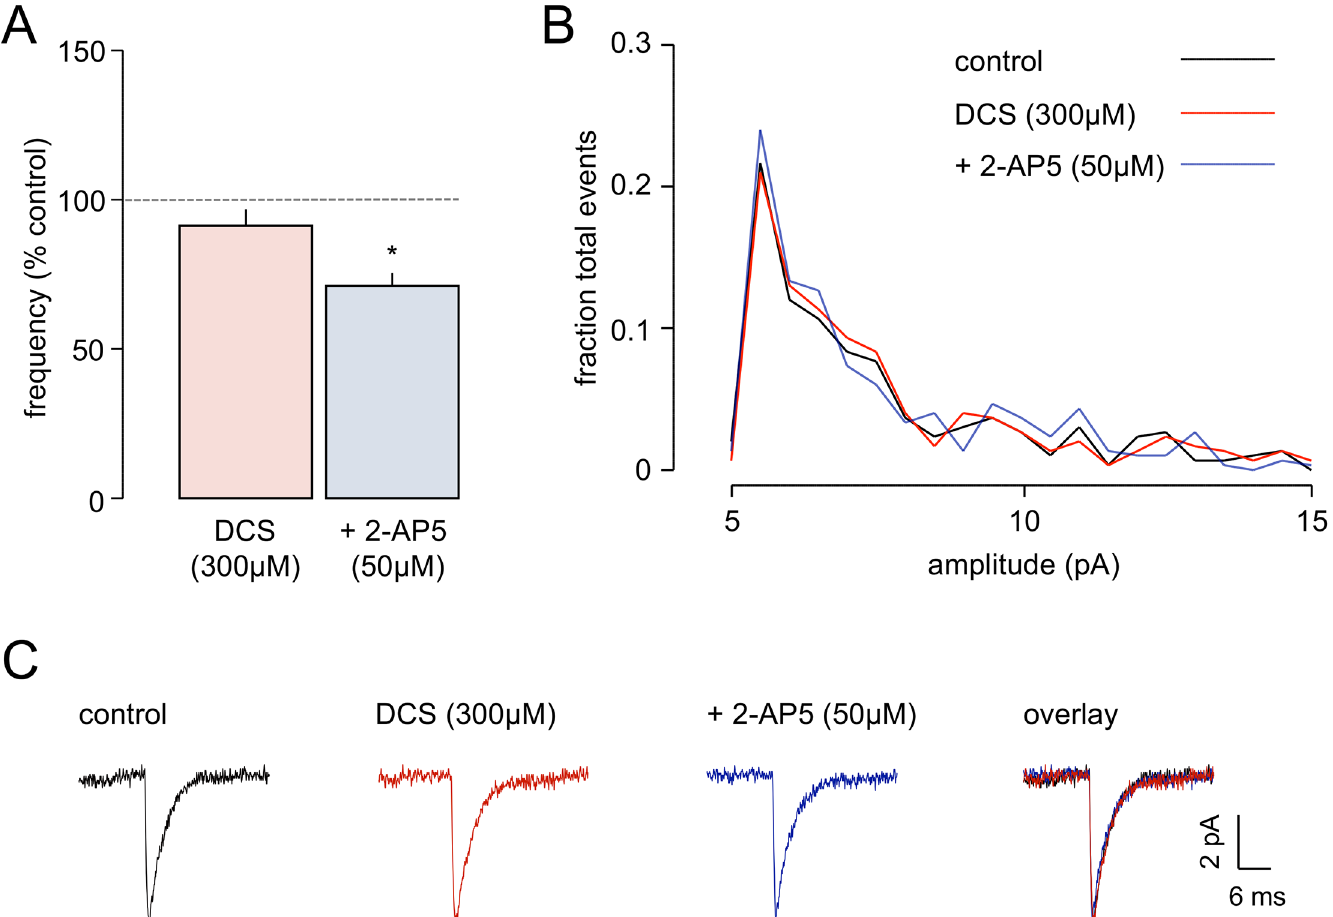
Fig 1. Effects of DCS on preNMDAr activity. A. The histograms show average normalised changes in frequency of mEPSCs with DCS and 2-AP5 in six neurones. DCS was without effect whereas subsequent, cumulative addition of 2-AP5 reduced frequency by ~30%. B. The graphs show that the frequency distribution of amplitudes of mEPSCs was unaltered by either antagonist. C. Average mEPSCs (n = 20) in one neurone showing the lack of change in amplitude, rise or decay time with either drug. * P <